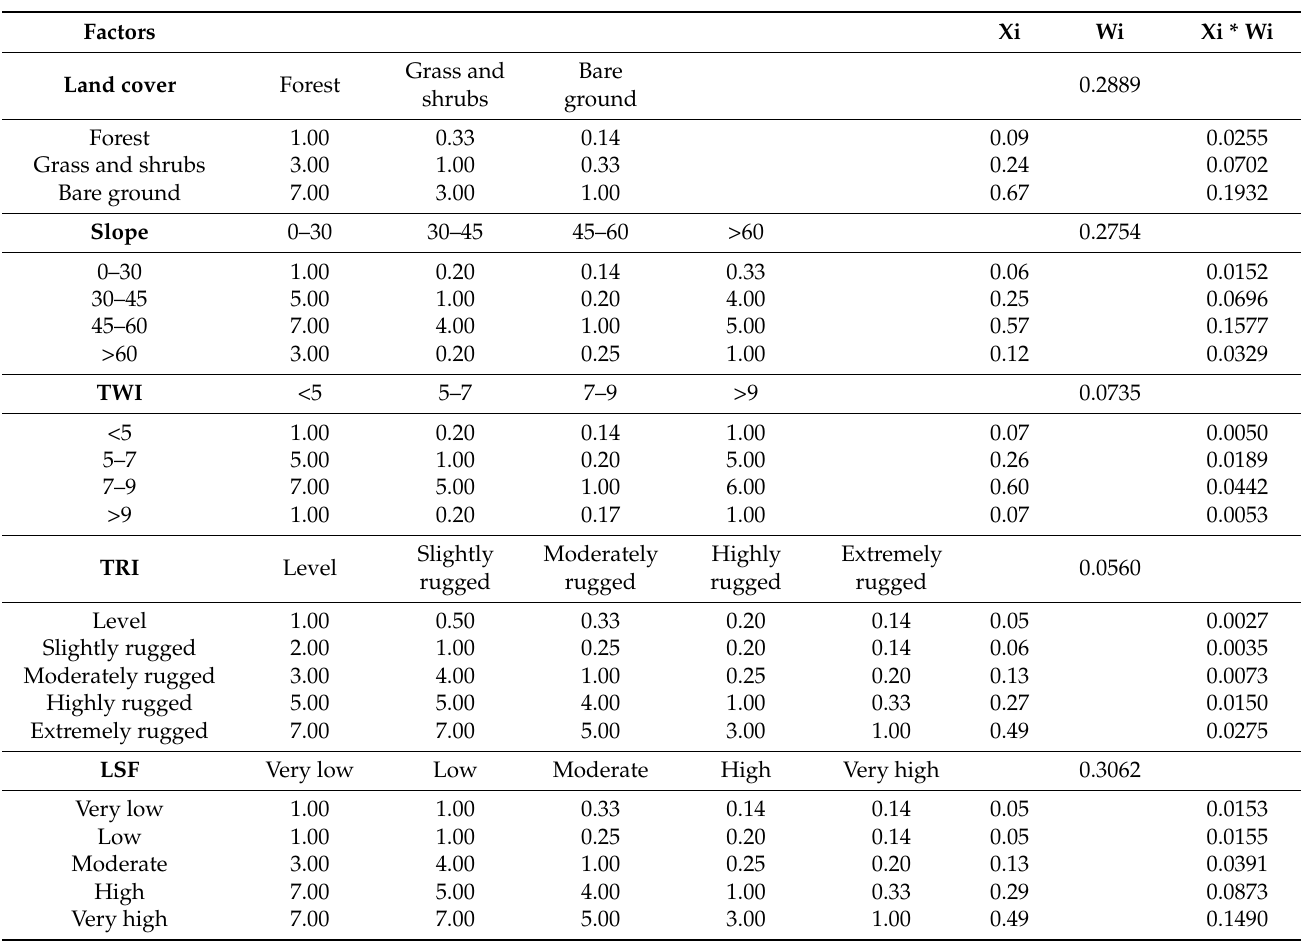
Table 4. The pairwise comparison matrix for classes: 1—equal importance, 2—weak importance, 3—moderate importance, 4—moderate plus, 5—strong importance, 6—strong plus, 7—very strong